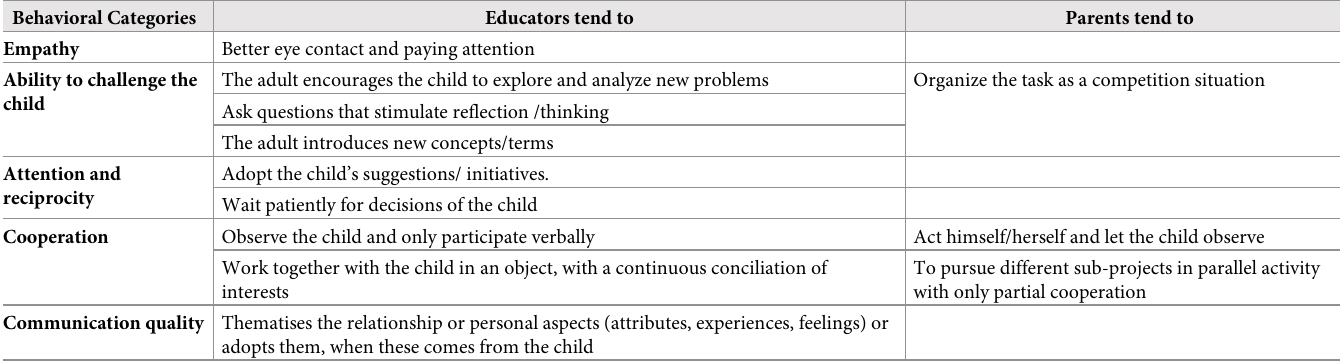
Table 5. Summary of interactive behavior differences in educators and parents.